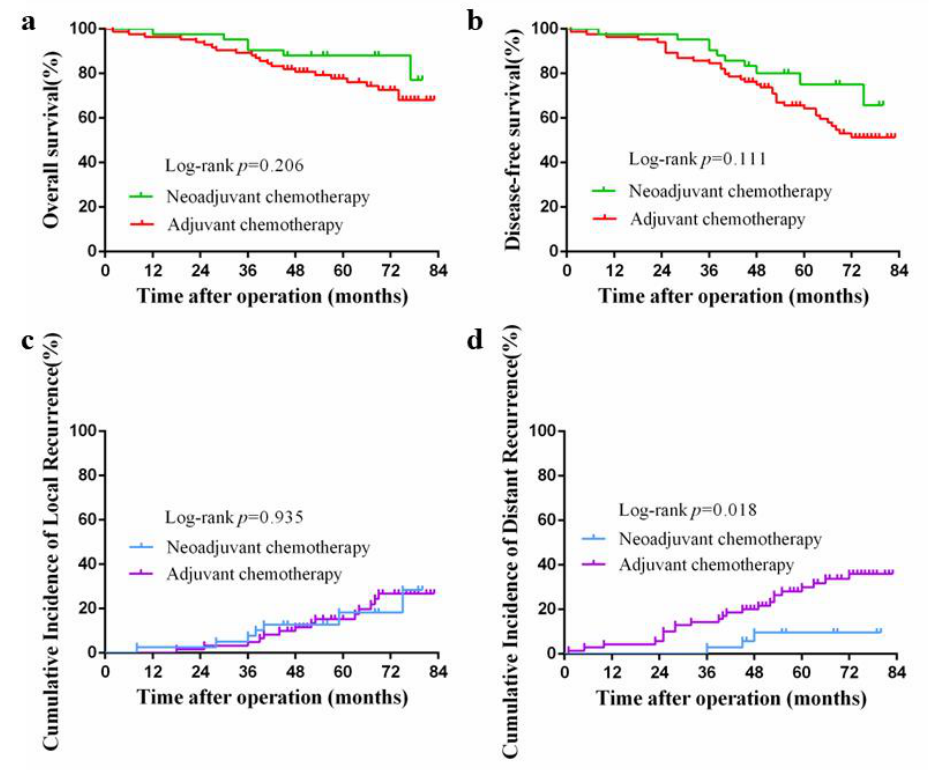
Figure 2. ( a ) Kaplan – Meier curve for overall survival after propensity score matching; ( b ) Kaplan–Meier curve for disease-free survival after propensity score matching; ( c ) Kaplan–Meier curve for cumulative incidence of local recurrences; ( d ) Kaplan–Meier curve for cumulative incidence of distant recurrences.